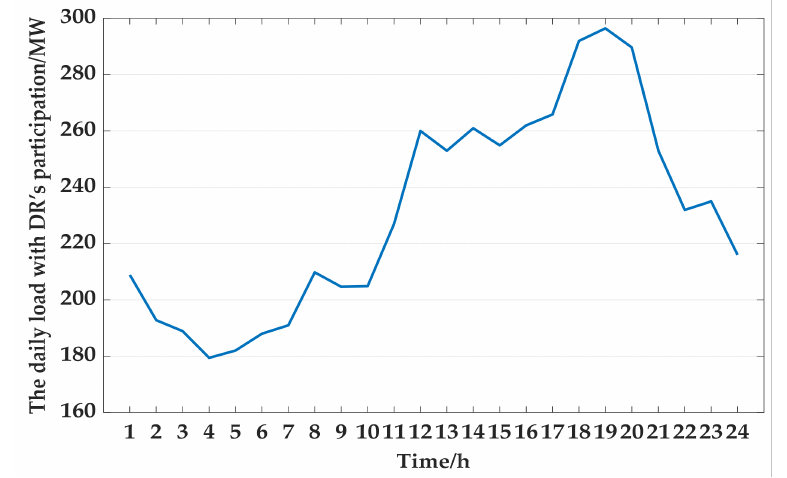
Figure 10. The daily load with DR participation in Case